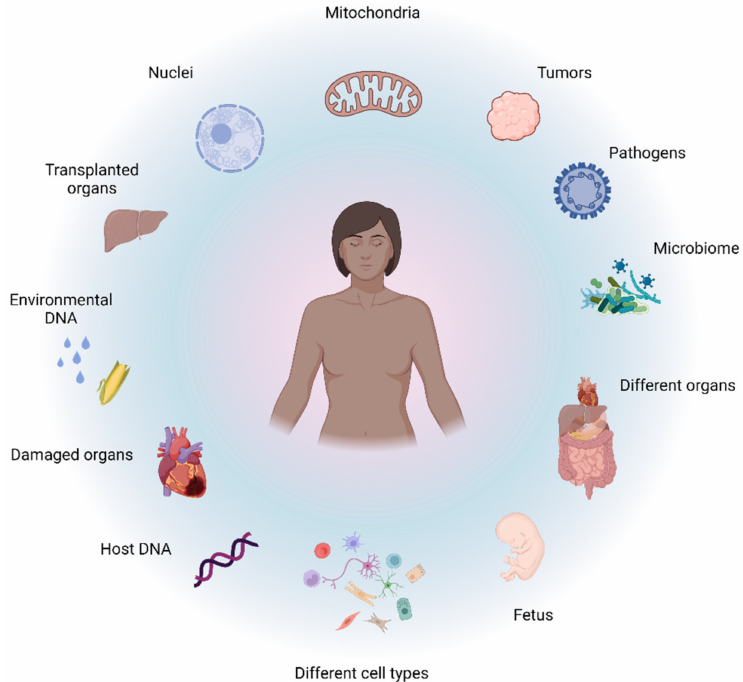
Figure 1. The diverse possible origins of cfDNA in humans. Through various pathways of cell death, clearance, and regulated release, whole or partial genomes of diverse origins are constantly shed into human body fluids in the form of fragmented